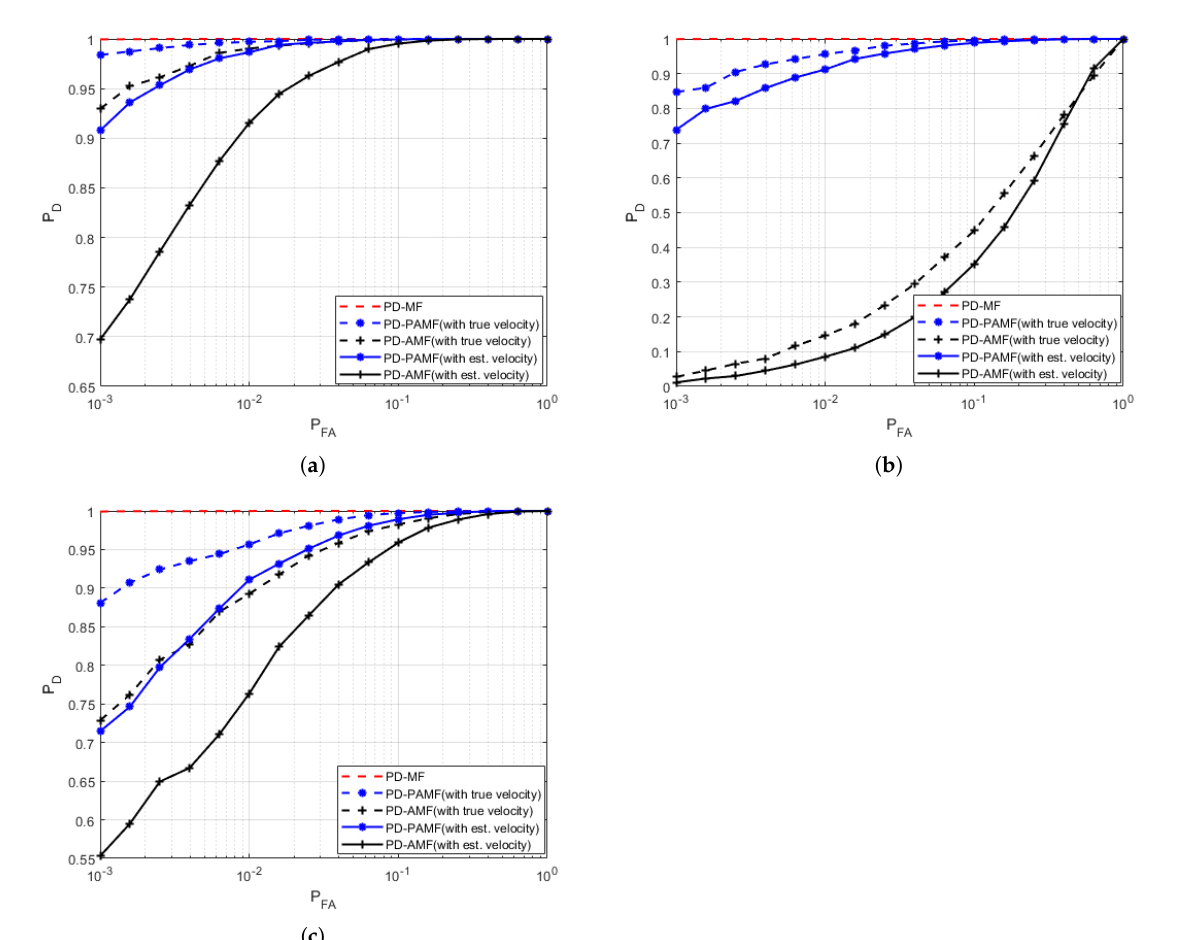
Figure 3. Receiver Operating Characteristic (ROC) curves ( a ) AR(5), K = 2 N = 22; ( b ) AR(3), K = 11; and ( c ) one target in training data, PD-PAMF: AR(5), K = 11, PD-AMF: K = 2 N =